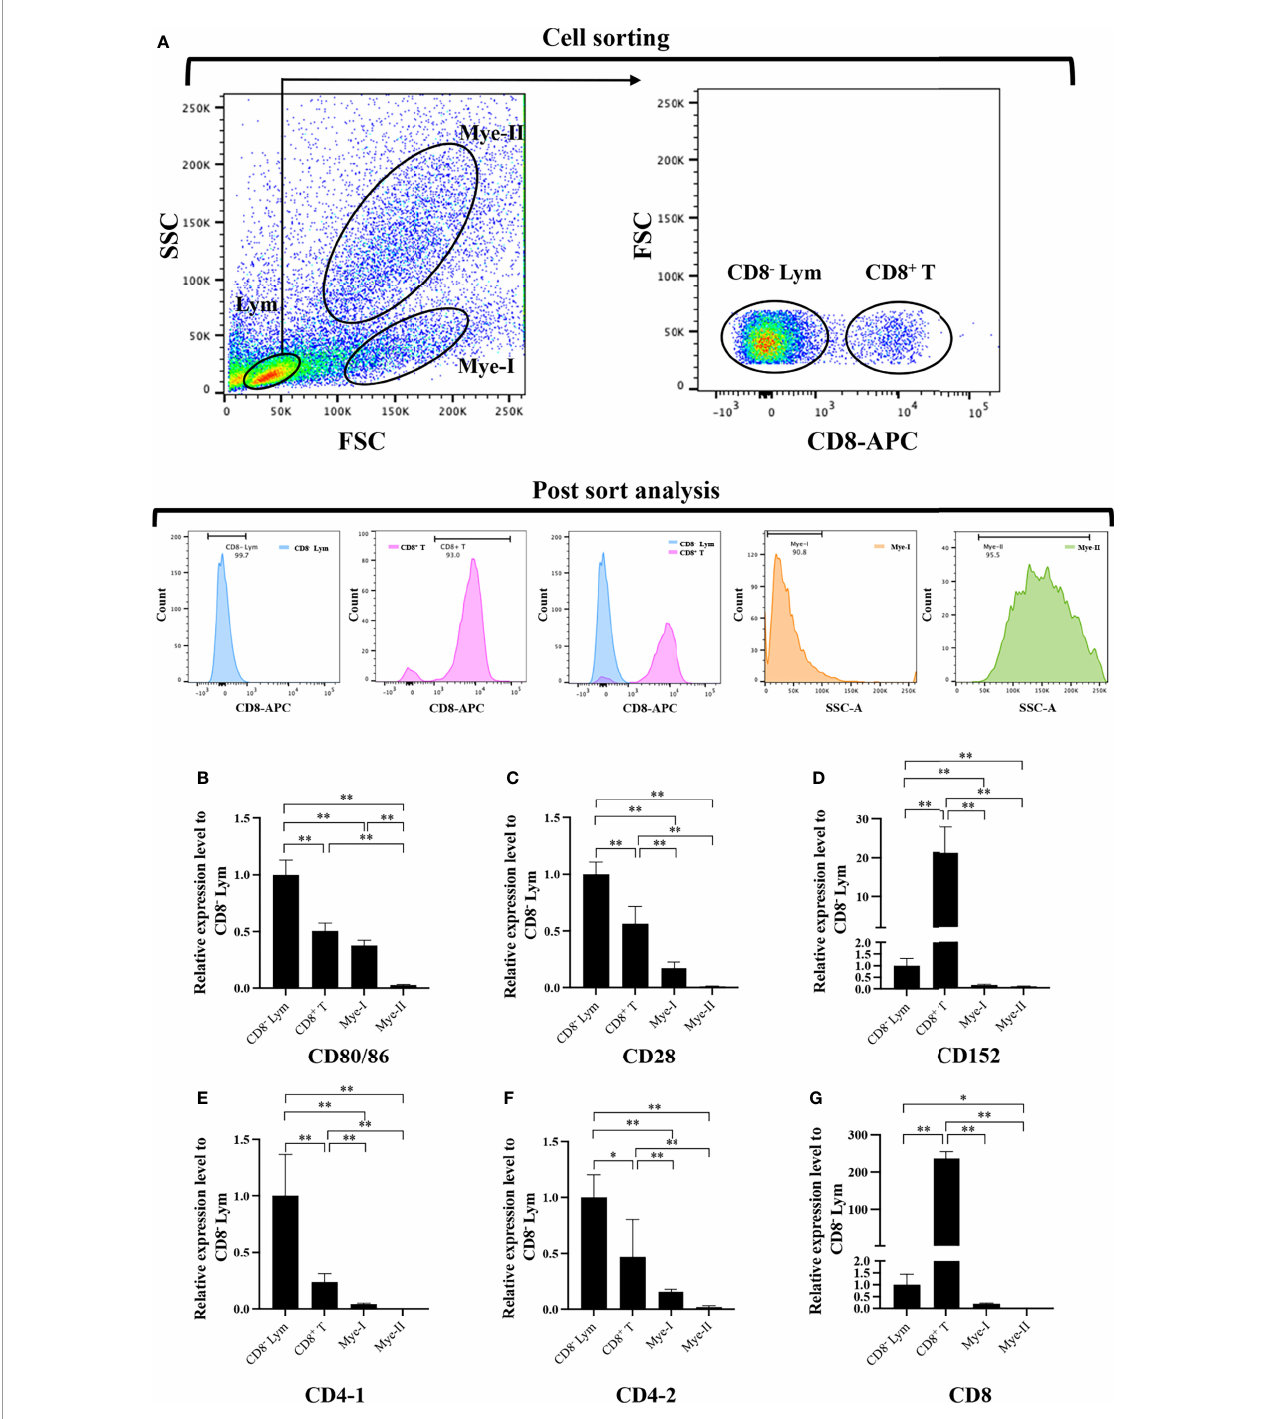
FIGURE 7 | Expression patterns of the grass carp CD80/86, CD28 , CD152 , CD4-1 , CD4-2 , and CD8 genes in head kidney leukocyte populations stained with rat anti-carp CD8 mAbs. (A) Flow cytometry analysis of the HKLs stained with rat anti-carp CD8 mAbs and APC-goat anti-rat IgG Abs. Four different cell populations were sorted: CD8 + T cells, CD8 - lymphocytes (Lym), myeloid I subset cells (Mye I), and myeloid II subset cells (Mye II). The purity of the sorted cells was analyzed by FACS. (B – G) The mRNA expression levels of CD80/86 (B) , CD28 (C) , CD152 (D), CD4-1 (E), CD4-2 (F) , and CD8 (G) genes in the four different cell populations were detected using qPCR. One representative result is represented by the fl ow cytometry dot plot. The mRNA expression levels were analyzed by qPCR and normalized against b -actin using the 2 − D Ct method. The p value was calculated using ANOVA with the LSD post hoc test (* p < 0.05, ** p < 0.01). Data are presented as mean ± SEM (n = 3 fi